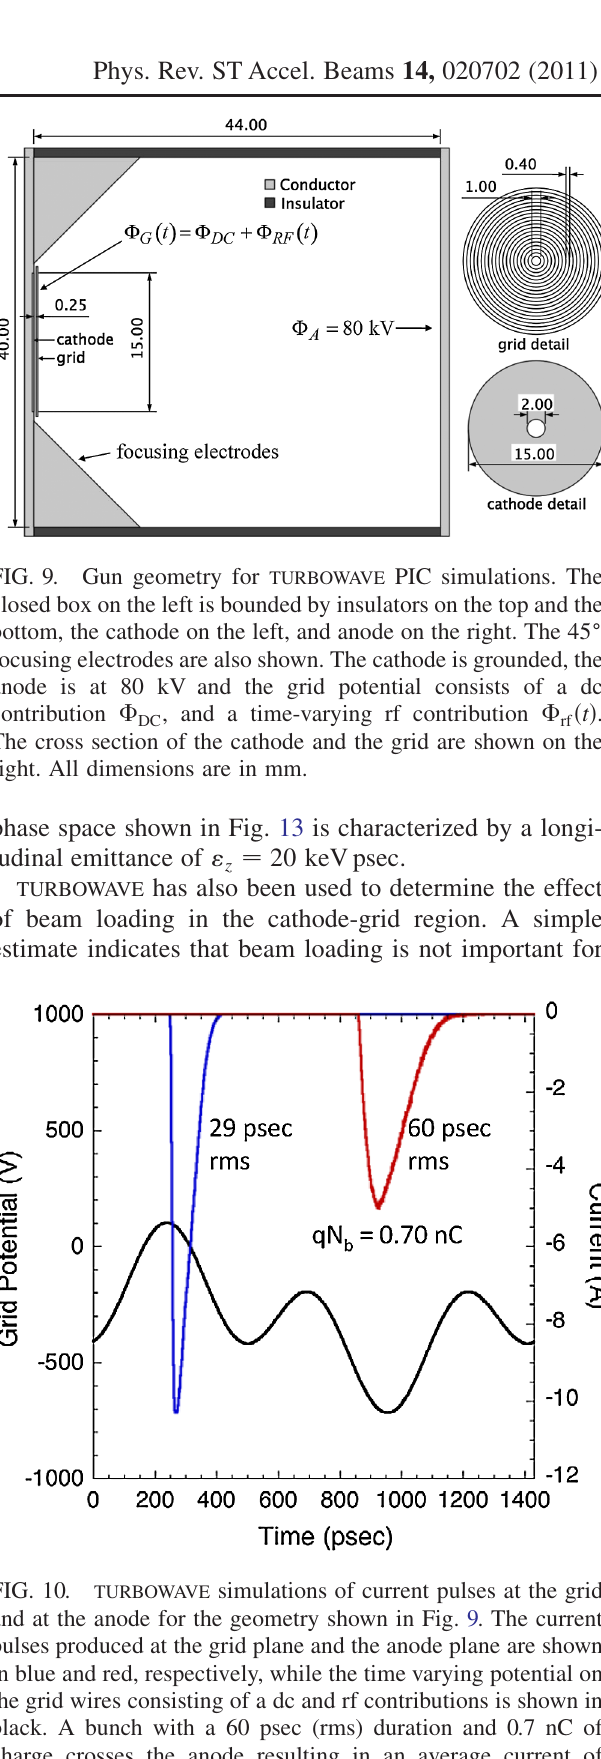
FIG. 10. TURBOWAVE simulations of current pulses at the grid and at the anode for the geometry shown in Fig. 9. The current pulses produced at the grid plane and the anode plane are shown in blue and red, respectively, while the time varying potential on the grid wires consisting of a dc and rf contributions is shown in black. A bunch with a 60 psec (rms) duration and 0.7 nC of charge crosses the anode resulting in an average current of h I b i ¼ 0 : 5 A